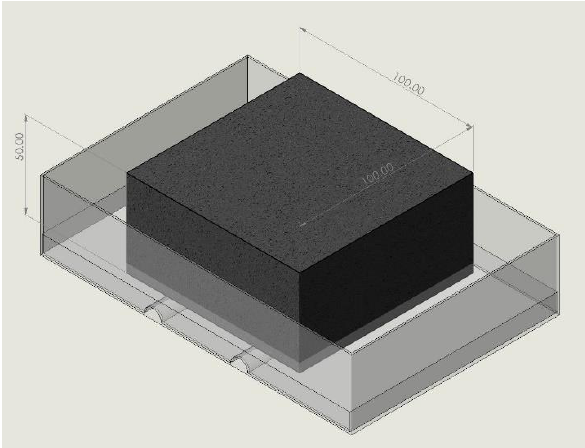
Figure 3. Sorption experiment setup (unit: mm).